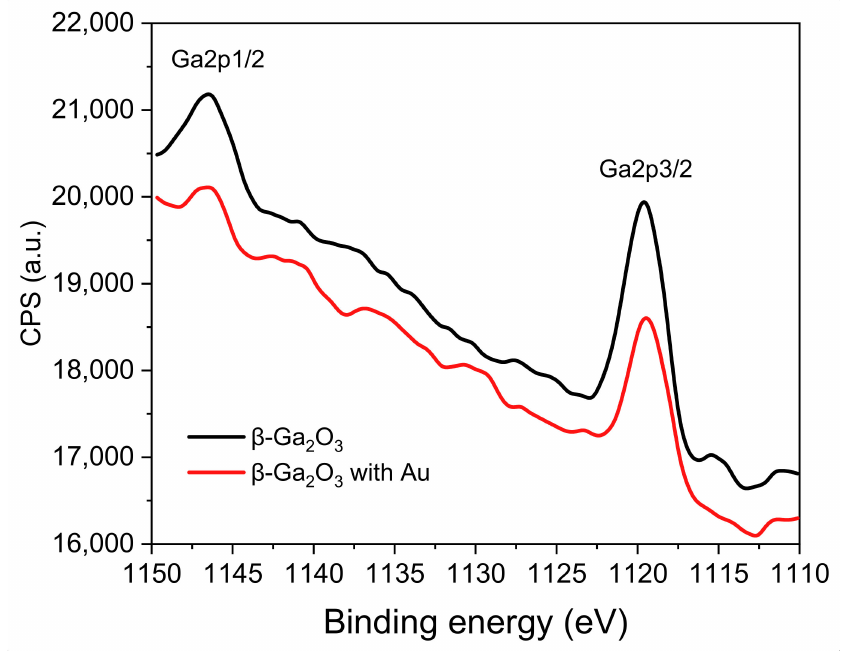
Figure 8. XPS spectra in the Ga2p region of β -Ga 2 O 3 epitaxial layer before and after impregnation with Au